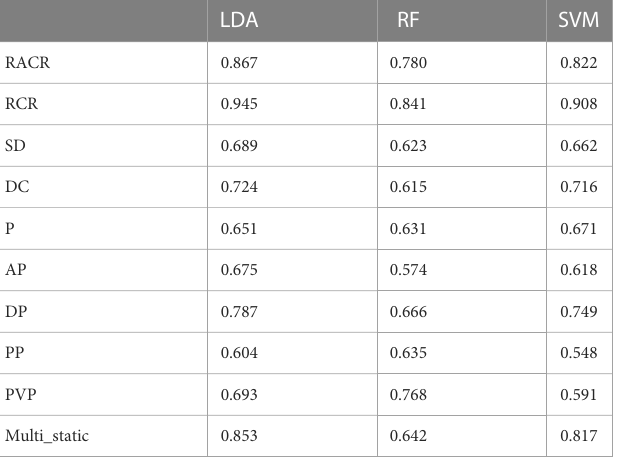
TABLE 3 Prediction AUCs based on various dimensions of LDA, RF and SVM.